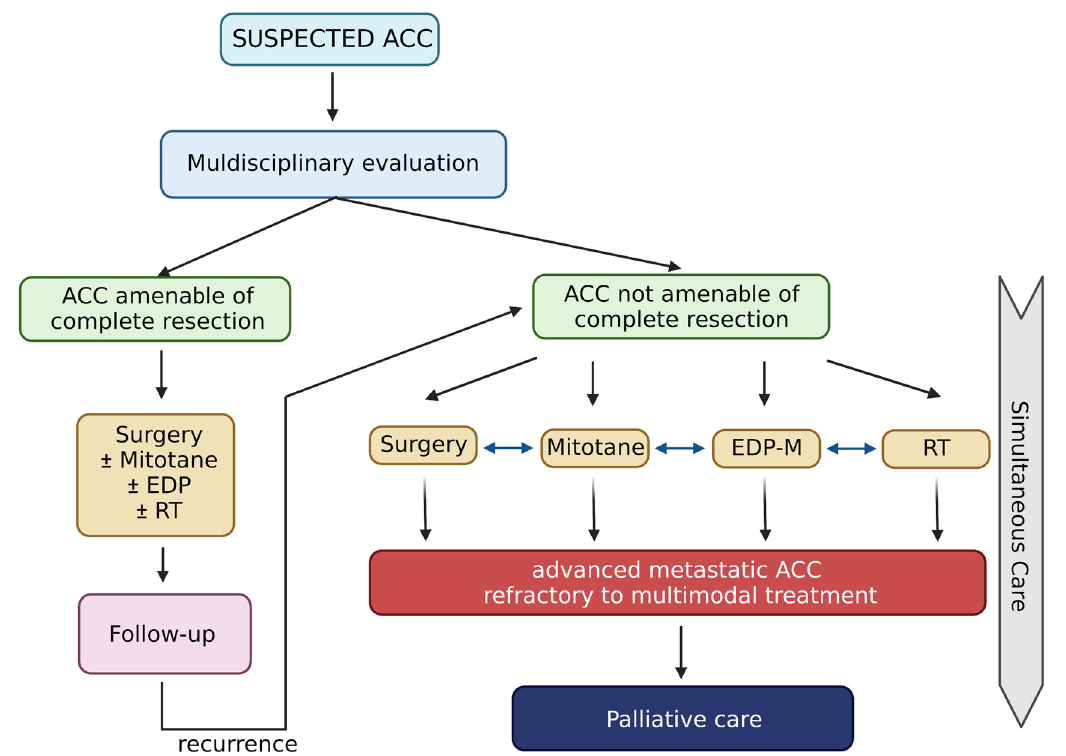
Figure 1. Life-prolonging curative treatment for patients with ACC. Created with BioRender.com. Two phase III randomized trials (ADIUVO-2 and ACACIA; NCT03583710 and